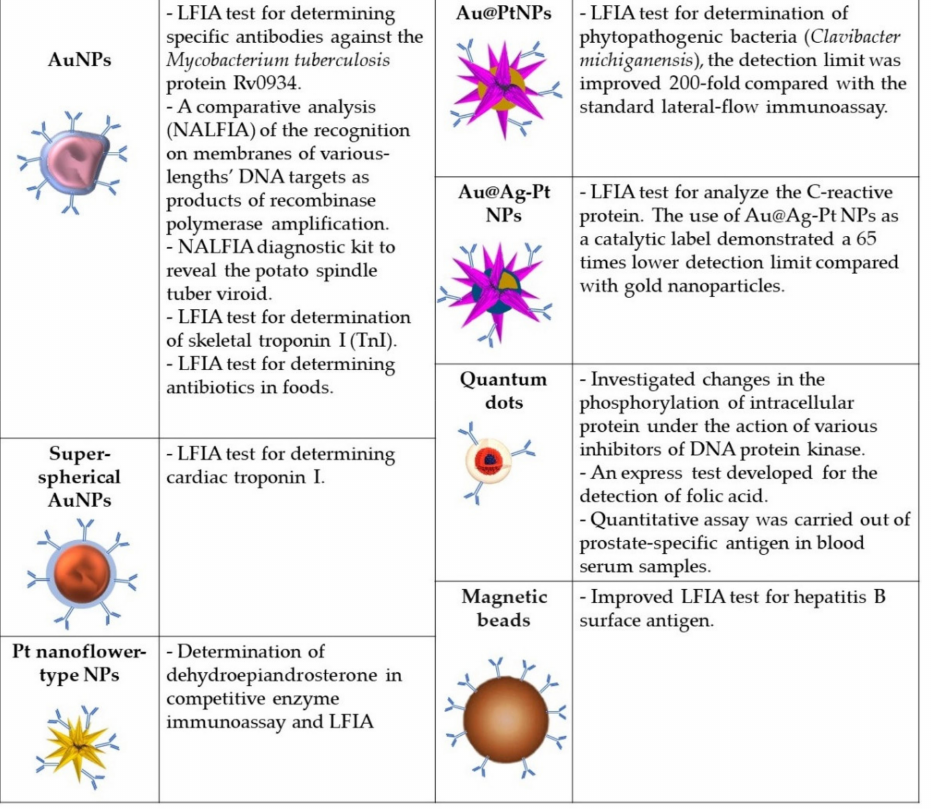
Figure 4. Useful modifications of nanoparticles for improvement of the analyte detection de- scribed in this review: AuNPs [65–73], Superspherical AuNPs [74], Pt-nanoflower-type NPs [75], Au@PTNps [76], Au@Ag-PtNPs [77], quantum dots [78–80], magnetic beads